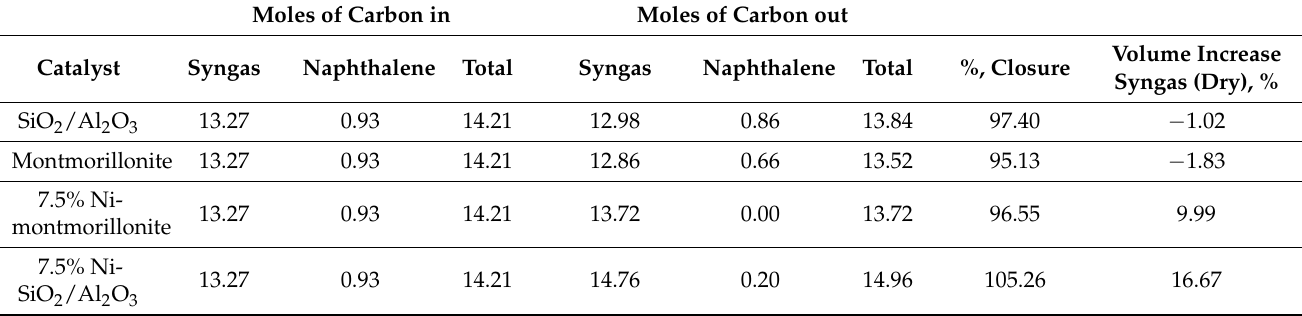
Table 2. Carbon balance: effect of a catalyst on naphthalene conversion (T—750 ◦ C, S/C—5.0, GHSV—12,800 h − 1 , naphthalene loading—12 g/Nm 3